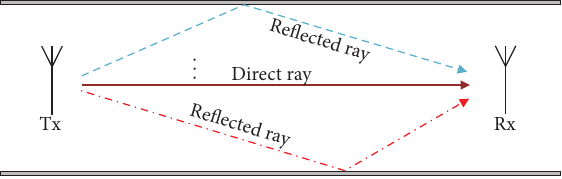
Figure 1: Signal propagation in a tunnel